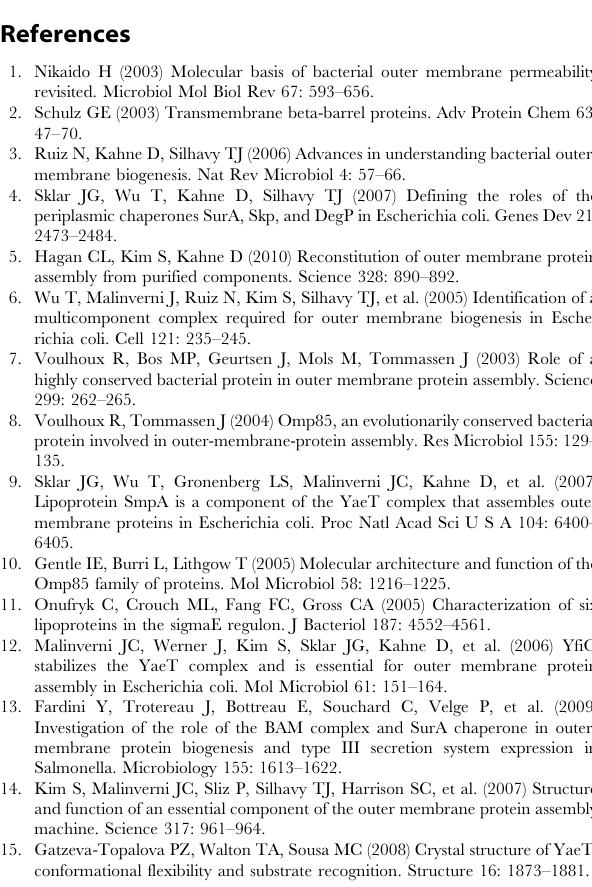
Table S1 Primers used in the construction of plasmids.